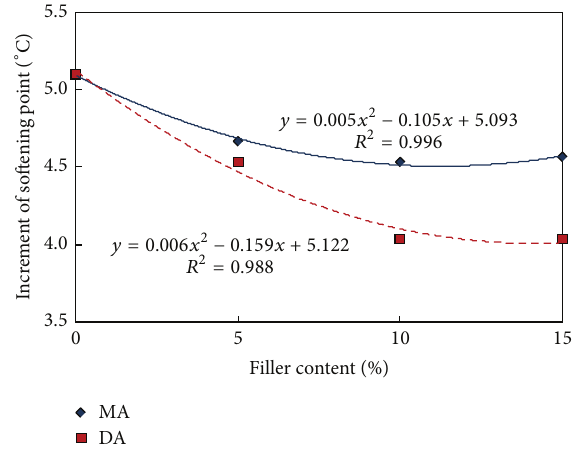
Figure 6: Increments of softening point of asphalt mastics versus content after TFOT.